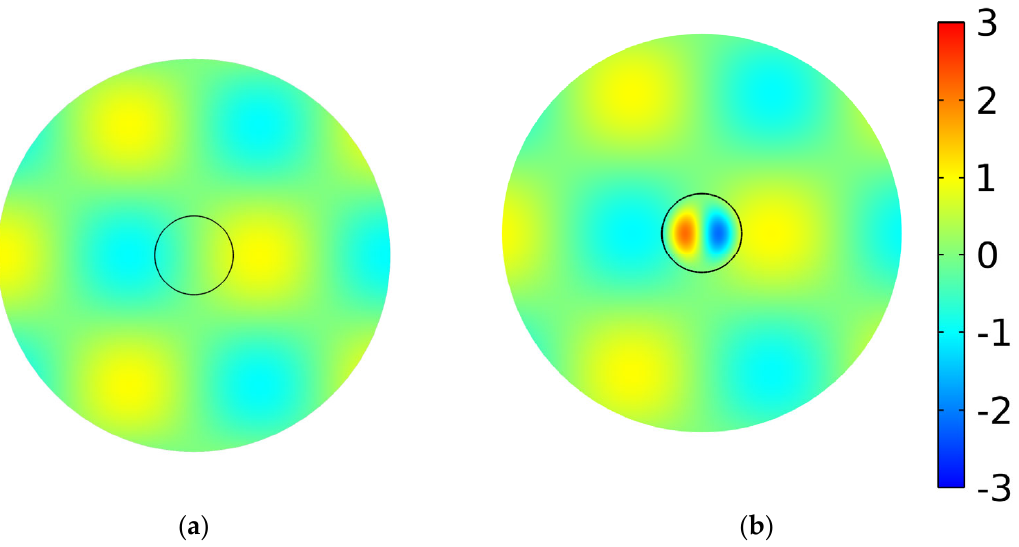
Figure 5. Spatial distribution ( a ) of the excitation field (17) and ( b ) of the total field in the presence of a nanowaveguide at a frequency k R ε = 4.36 for the perfect invisibility mode PTM 11 at R = 400 nm, ε = 12 and α = π /4.